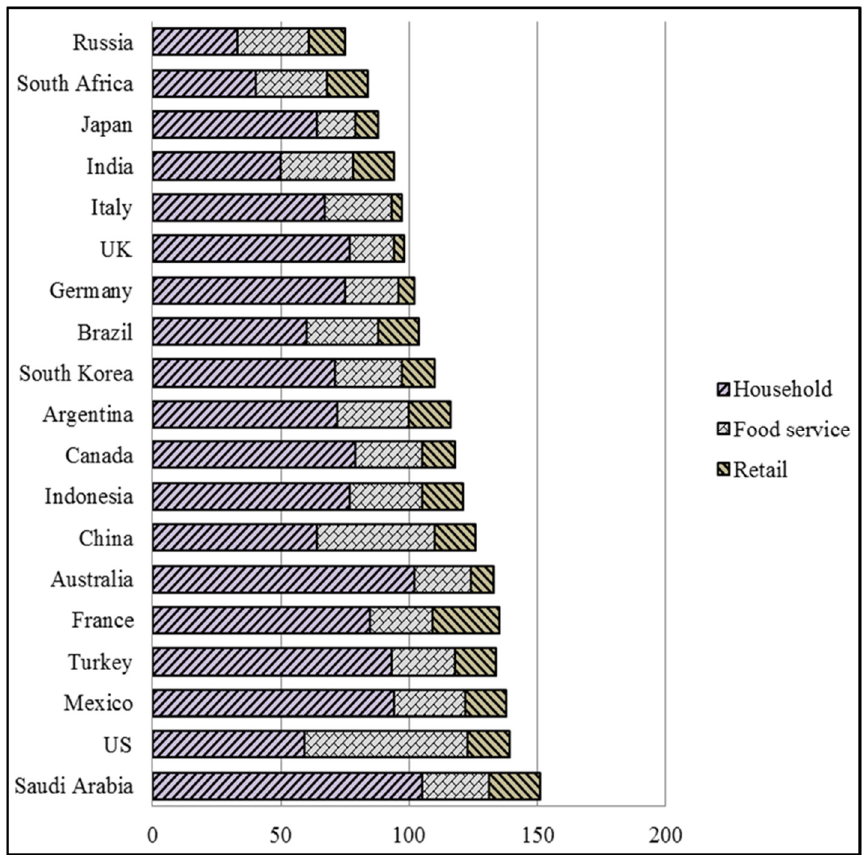
Figure 4. Food waste index flowchart (kg/head/year) 2021